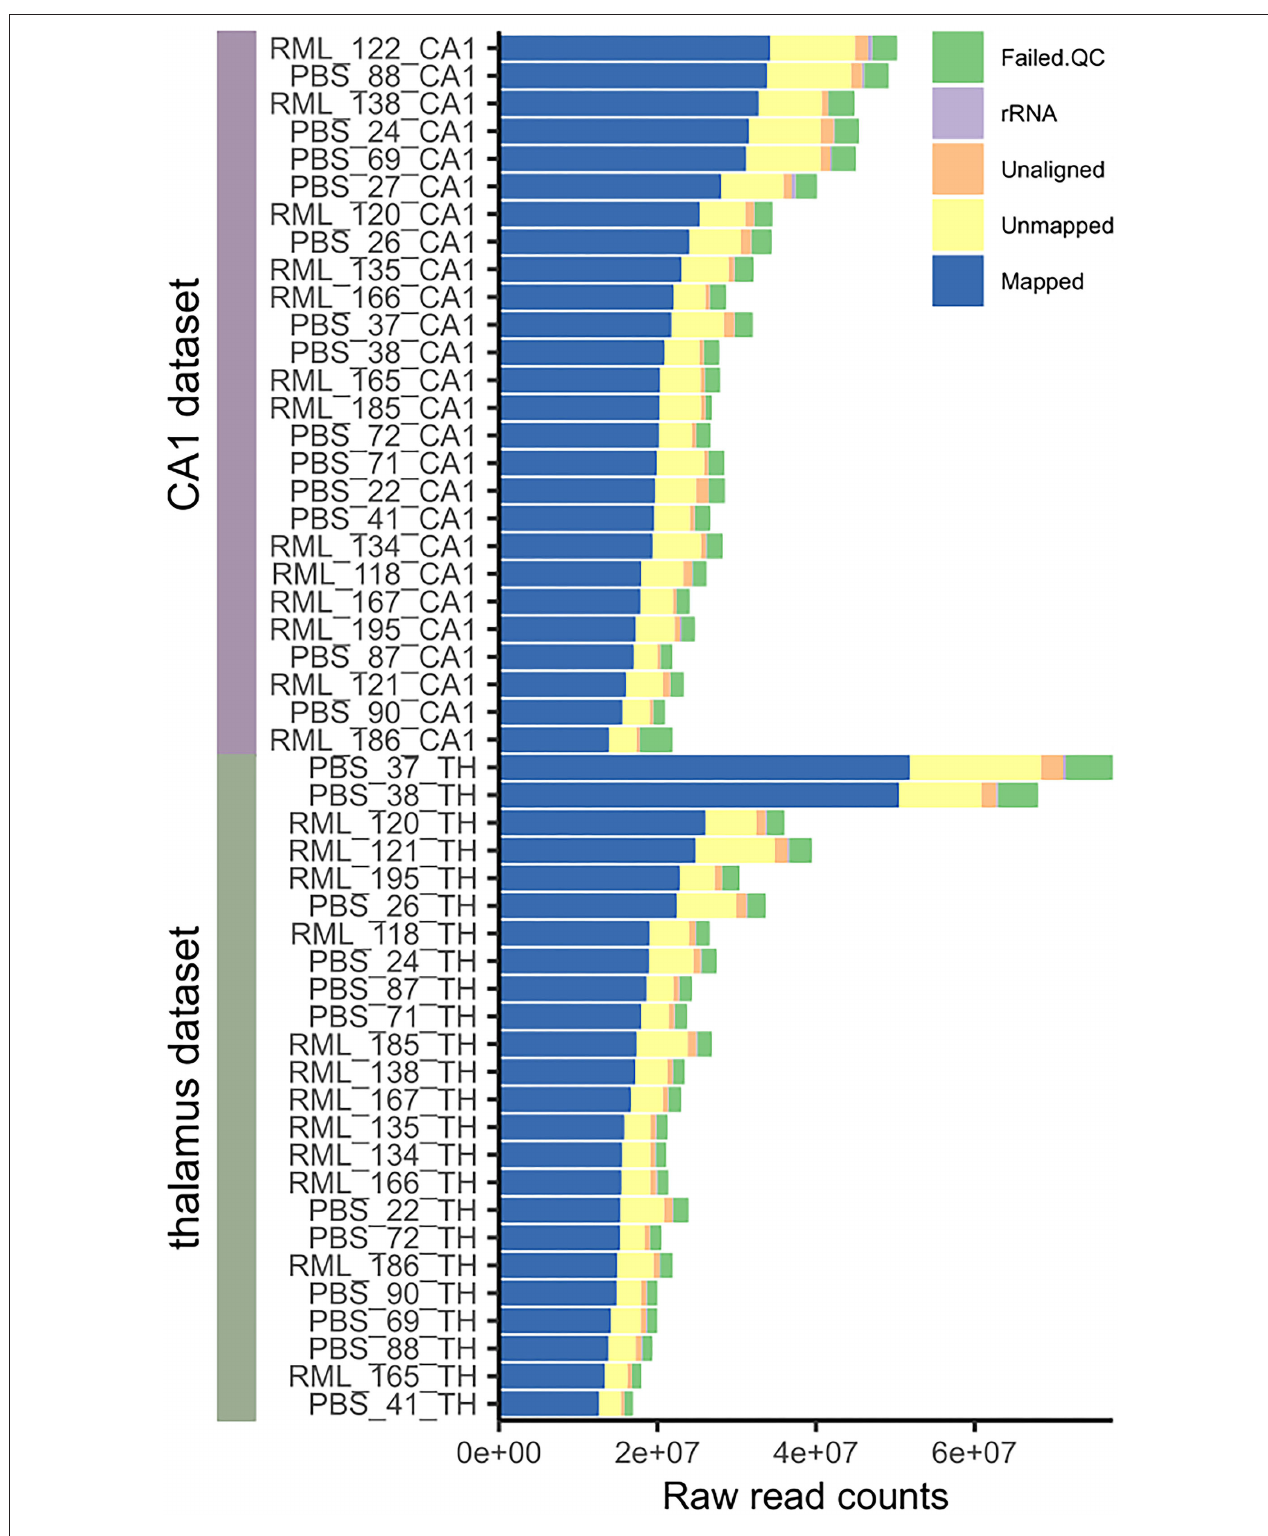
FIGURE 1 | Pre-processing mapping statistics of all microdissected CA1 and thalamus samples used in the analysis. The number of raw sequencing reads that failed quality control, were removed on the basis of mapping to rRNA, were not aligned to the genome, failed to map to a valid transcript, and were successfully mapped to a transcript are indicated. We aimed for 30–40 million raw sequencing read pairs per library and successfully mapped 15–30 million read pairs per library for the analysis.